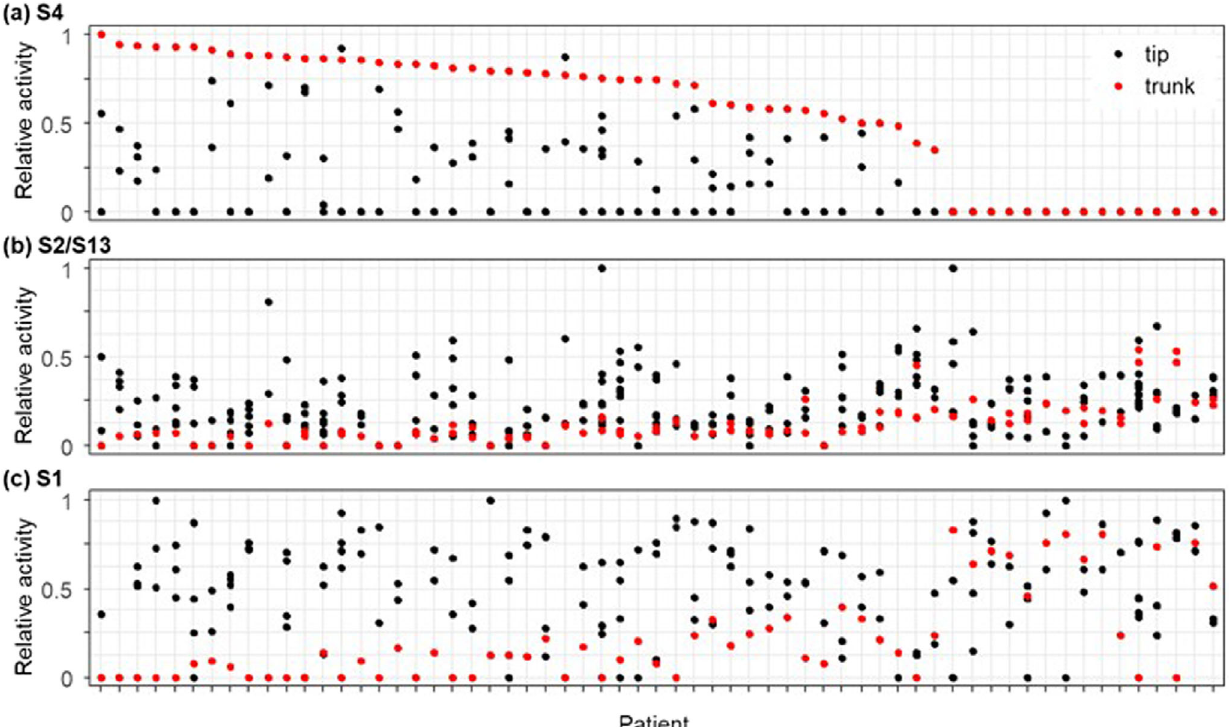
Fig. 7 Evolutionary dynamics of mutational signatures. Relative activities of signature S4 ( a ), S2/S13 ( b ), and S1 ( c ) in the trunk (red) and tip (black) branches are shown for each patient. Patients are ordered by the relative activity of S4 in the trunk.